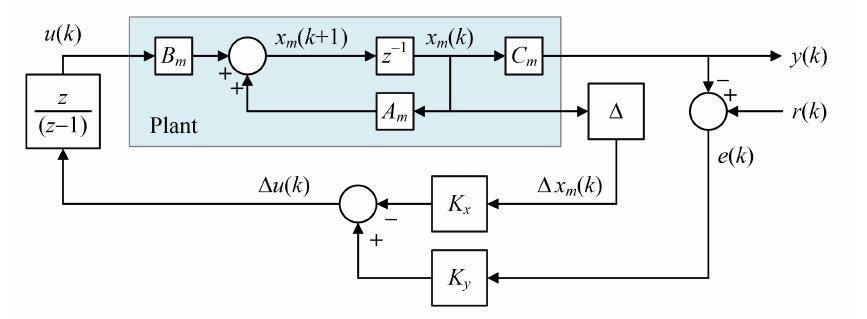
Figure 2. Conventional generalized predictive control described in